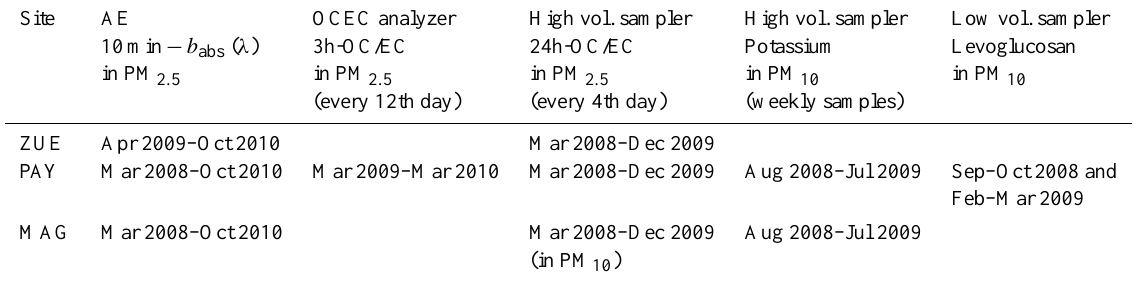
Table 1. Measurements performed at the Zurich-Kaserne (ZUE), Payerne (PAY) and Magadino-Cadenazzo (MAG) sites.